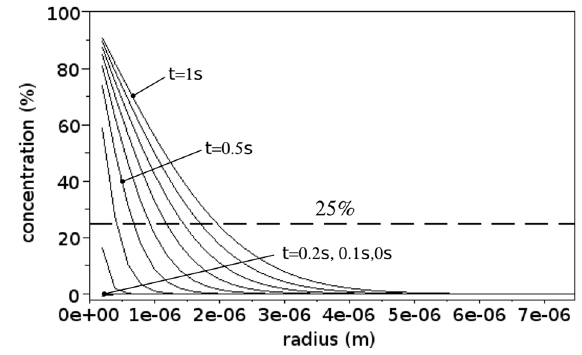
Figure 11. Titanium concentration in aluminum along the z axis.